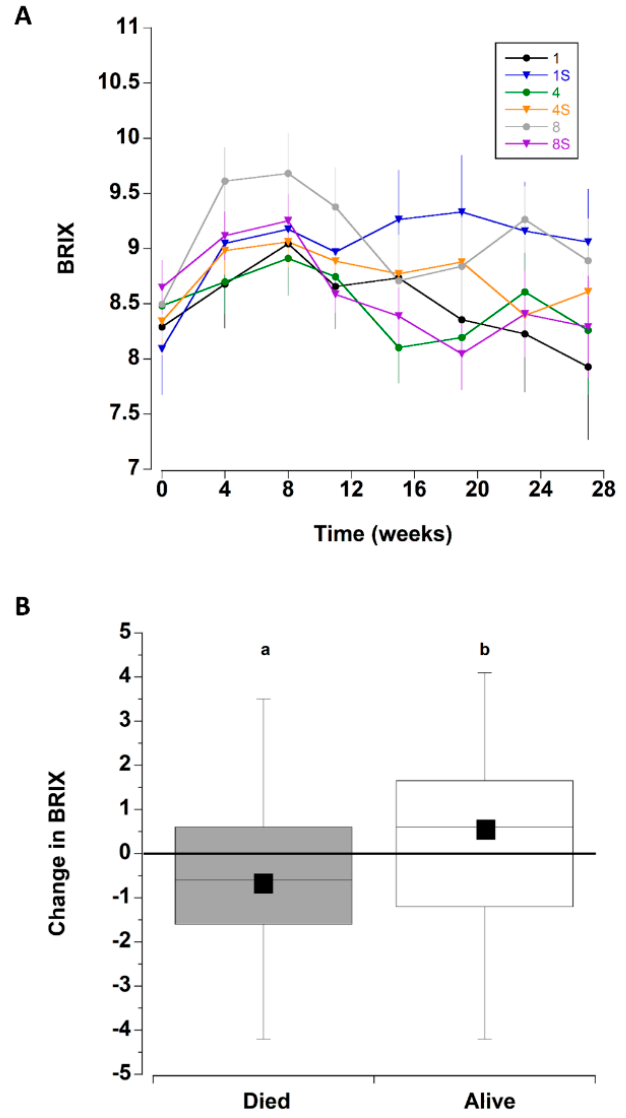
Figure 4. ( A ) BRIX values for C. maenas (mean ± SE) kept in densities of 1, 4 or 8 crabs, with (S) or without shelter. ( n = 24 per treatment) for six months in the laboratory. ( B ) Change in BRIX values (between first and last measurement) for crabs that died during the experiment (where the last measured value was used) and those that survived the six month experimental period. Data for the 6 different treatments was combined. The box plots represent the 75% confidence intervals, whiskers indicate the 95% confidence limits of the data, the horizontal line is the median number and the square is the mean number of limbs lost. Different letters above each box represent significant differences ( p <